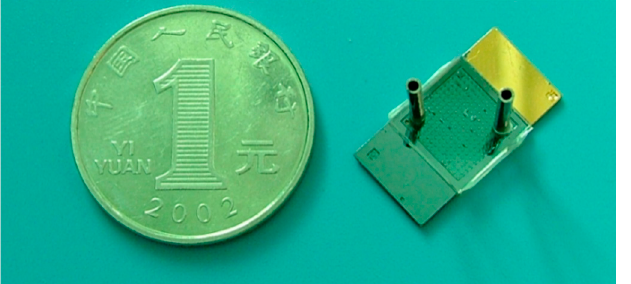
Figure 10. Photograph of an assembled self-breathing micro direct methanol fuel cell (µDMFC).